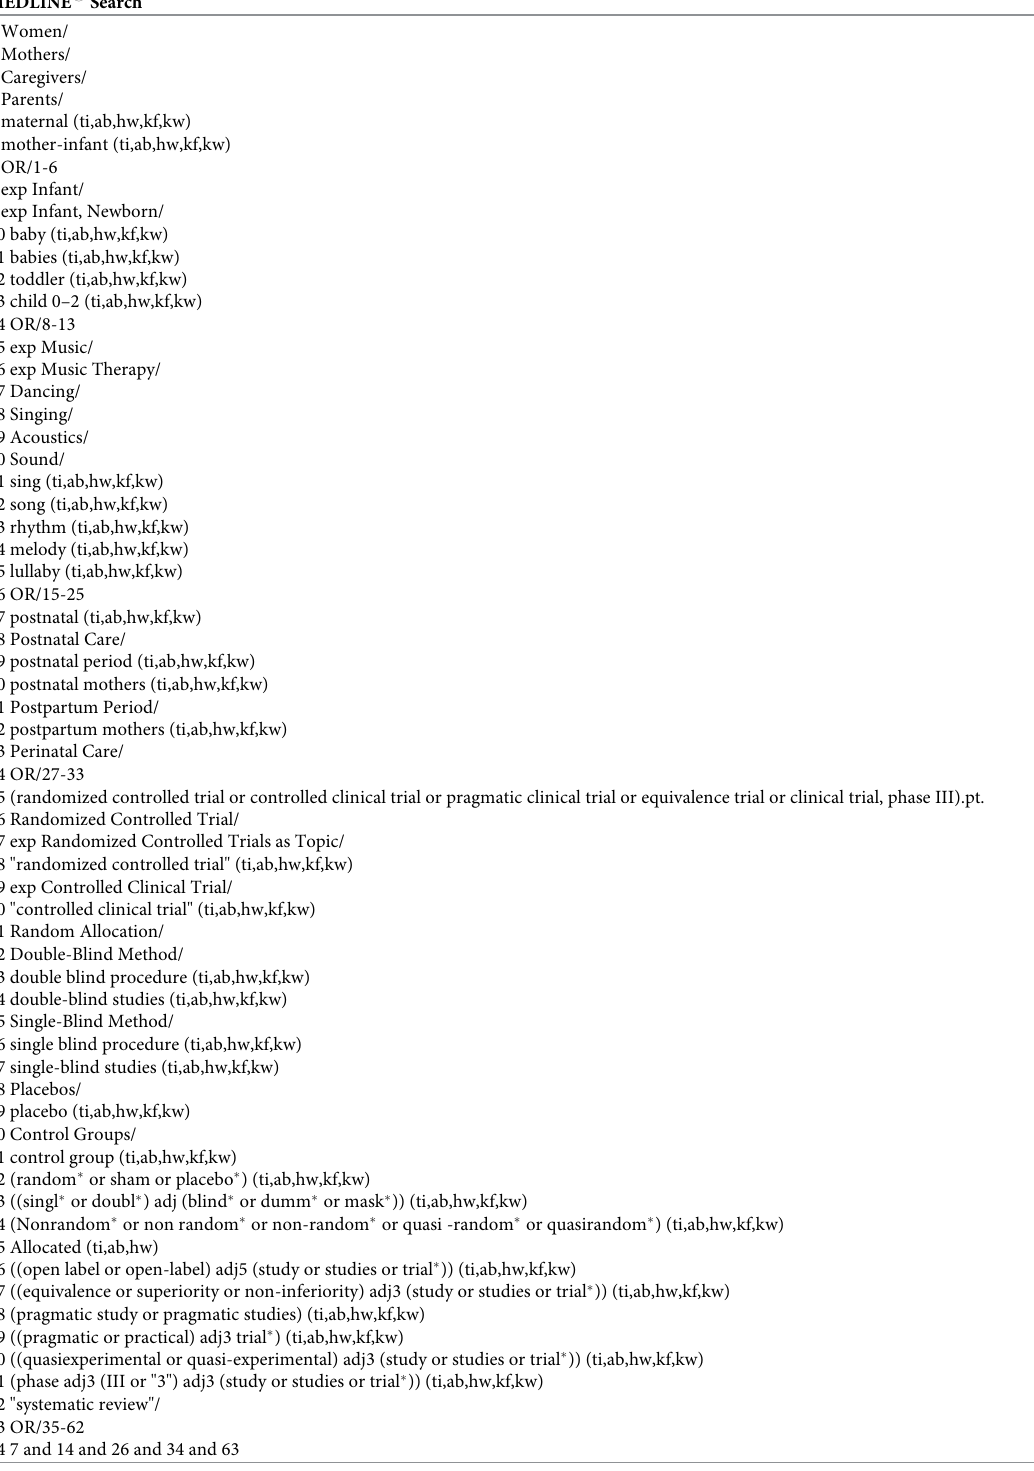
Table 1. Search terms and syntax for database searches, example from